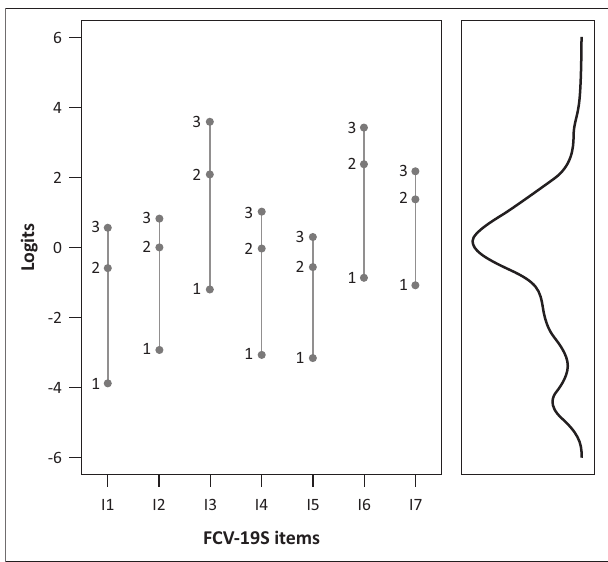
FIGURE 1 : Wright map with Rasch–Thurstone thresholds reported on the left and the person measure density plot on the right.